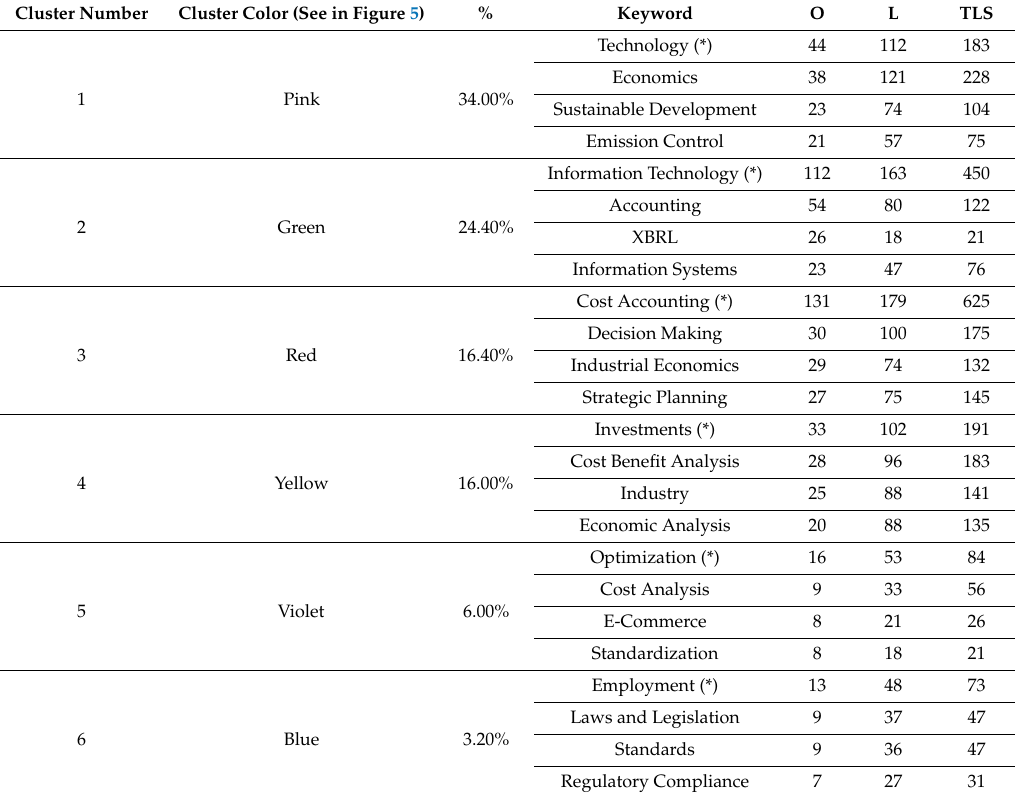
Table 5. Clusters of keywords